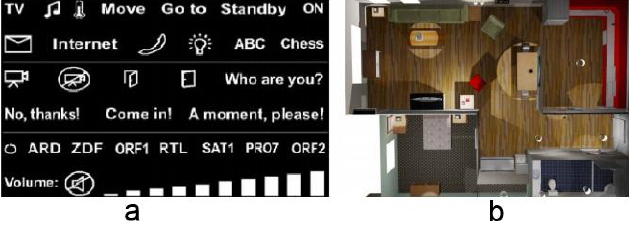
Fig. 8. A (a) P300-based BCI for controlling (b) a virtual domotics environment. Source: [44].